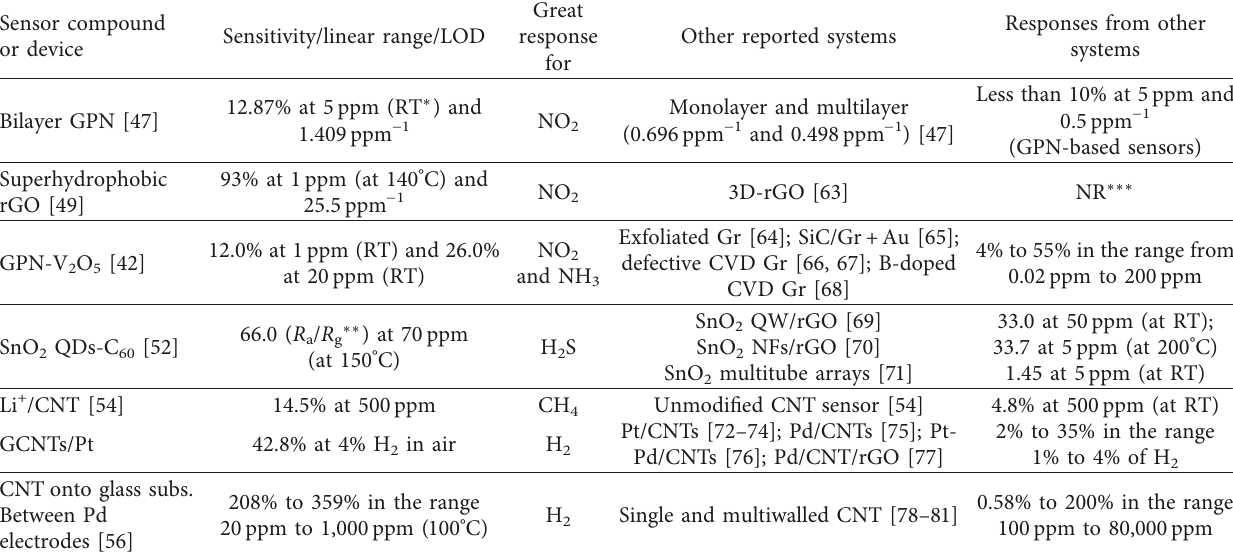
Table 1: Comparison between discussed gas sensor responses and different systems found in the literature. Sensor